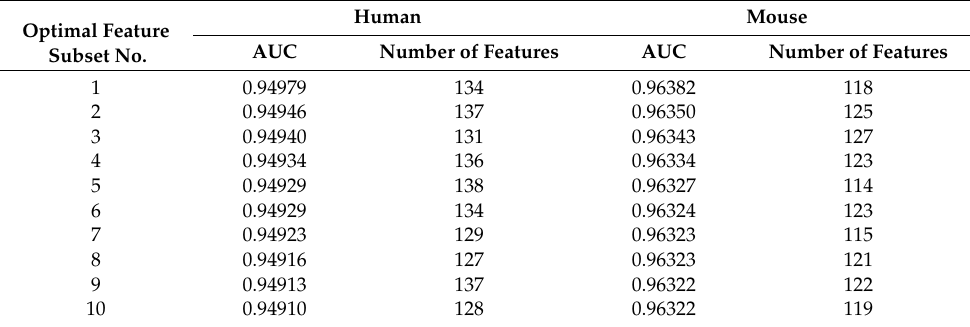
Table 3. Area under the curve (AUC) scores of models based on optimal feature subsets and sizes of optimal feature subsets for human and